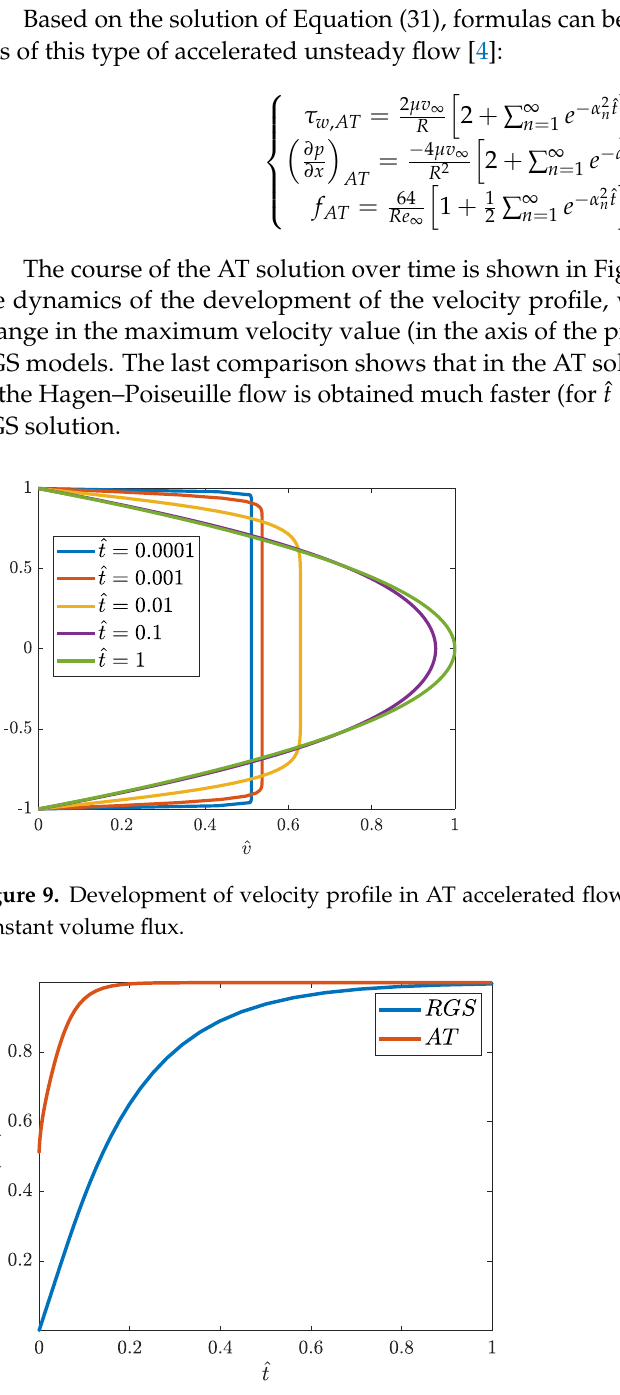
Figure 10. Normalized axial velocity comparison of RGS and AT solutions.